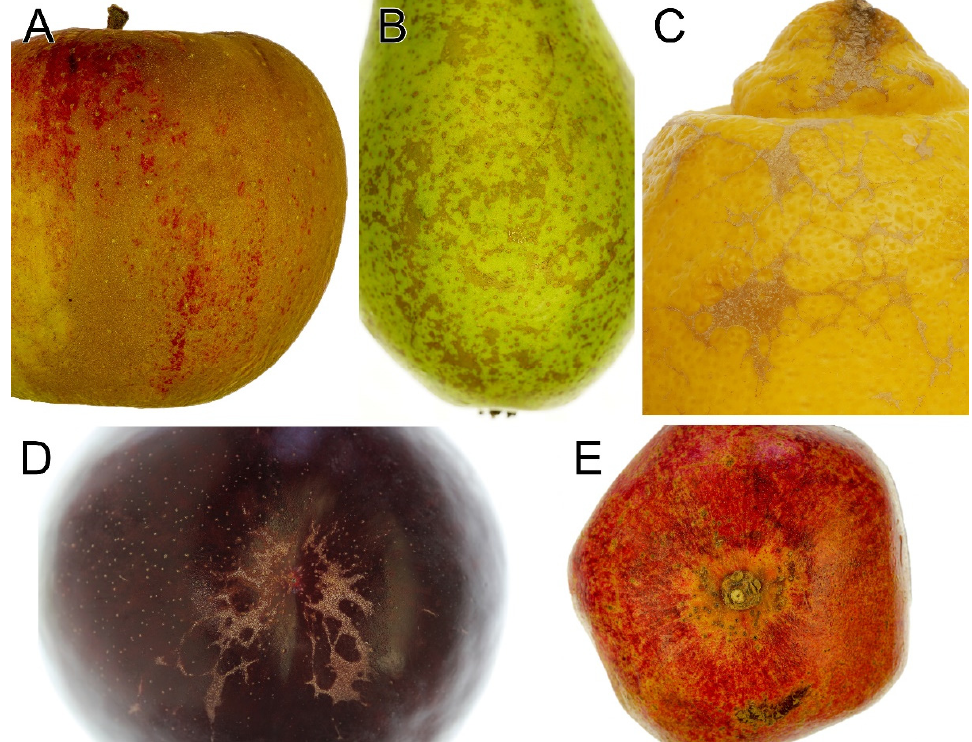
Figure 1. Russeting in different fruit crops. ( A ) Apple; ( B ) pear; ( C ) citrus; ( D ) plum; ( E ) pomegranate. Images: ( A , C ) Andreas Winkler, ( B , D , E ) Martin Brüggenwirth.